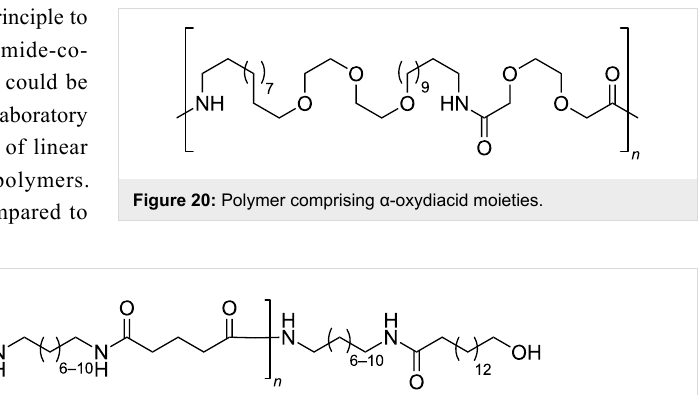
Mexiletine ( 38 ) was incorporated into amphiphilic poly(amine- co -ester)s through a two-step lipase catalyzed procedure.